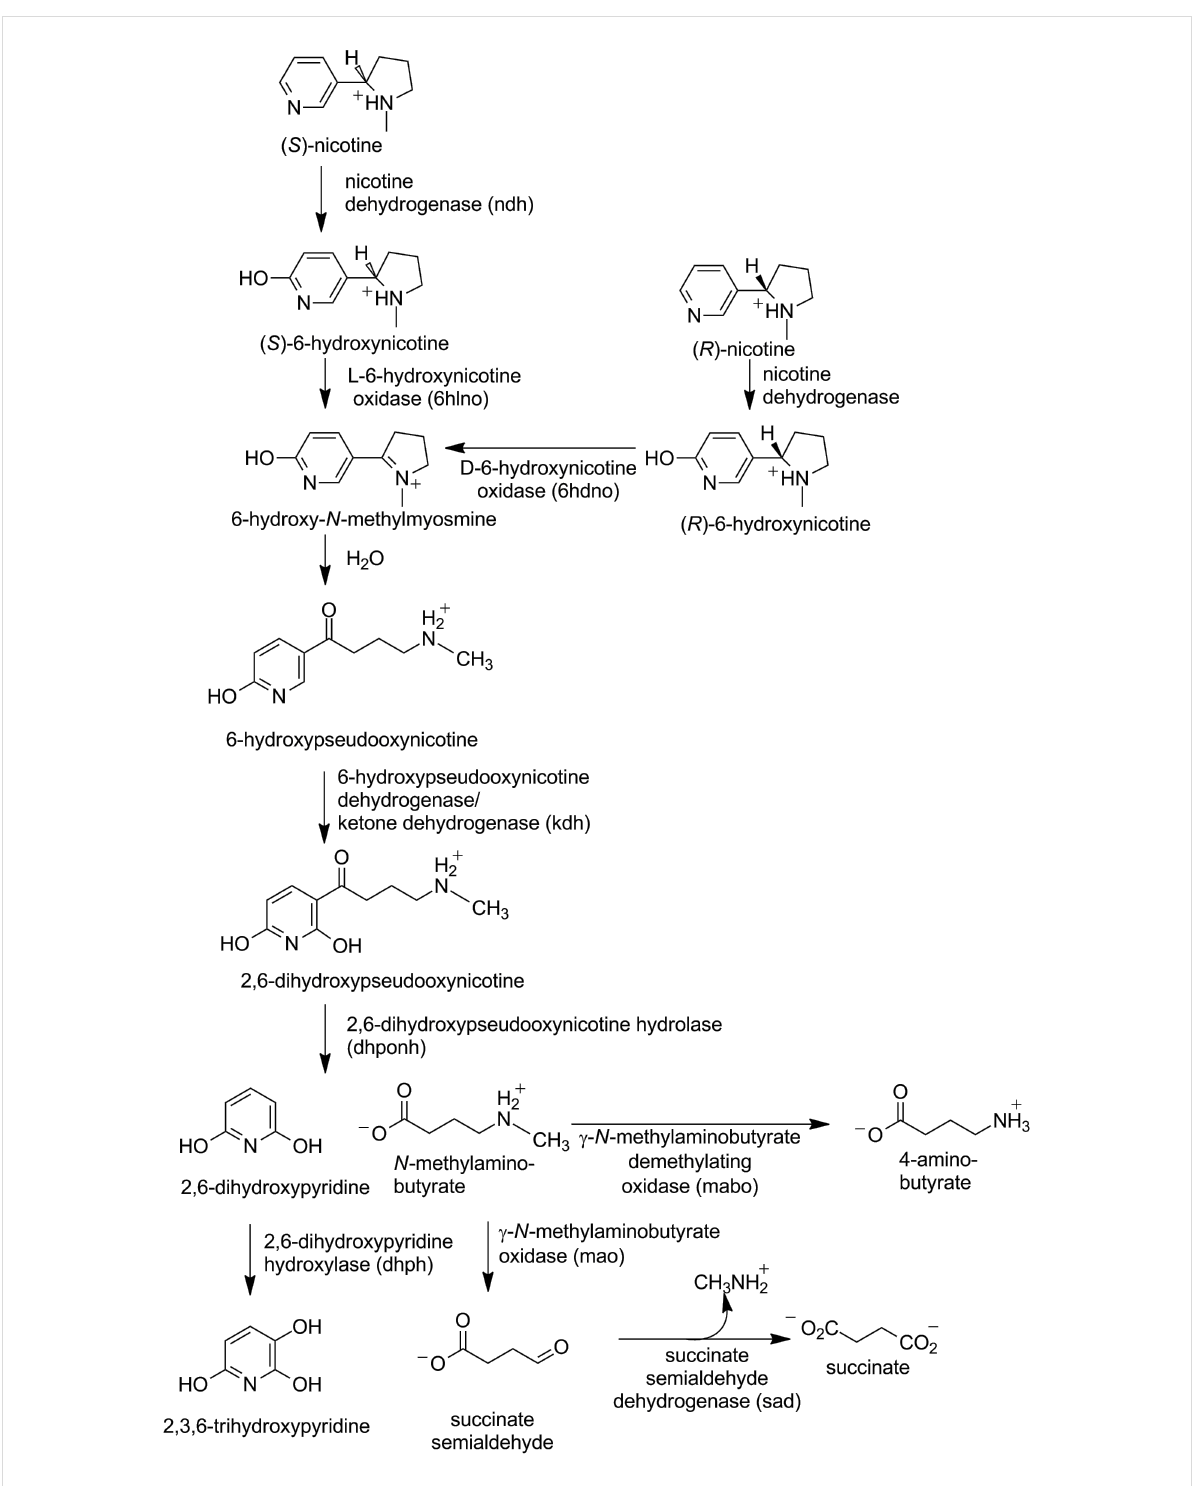
Scheme 1: Nicotine catabolism in A. nicotinovorans . The respective gene names are given in parentheses.